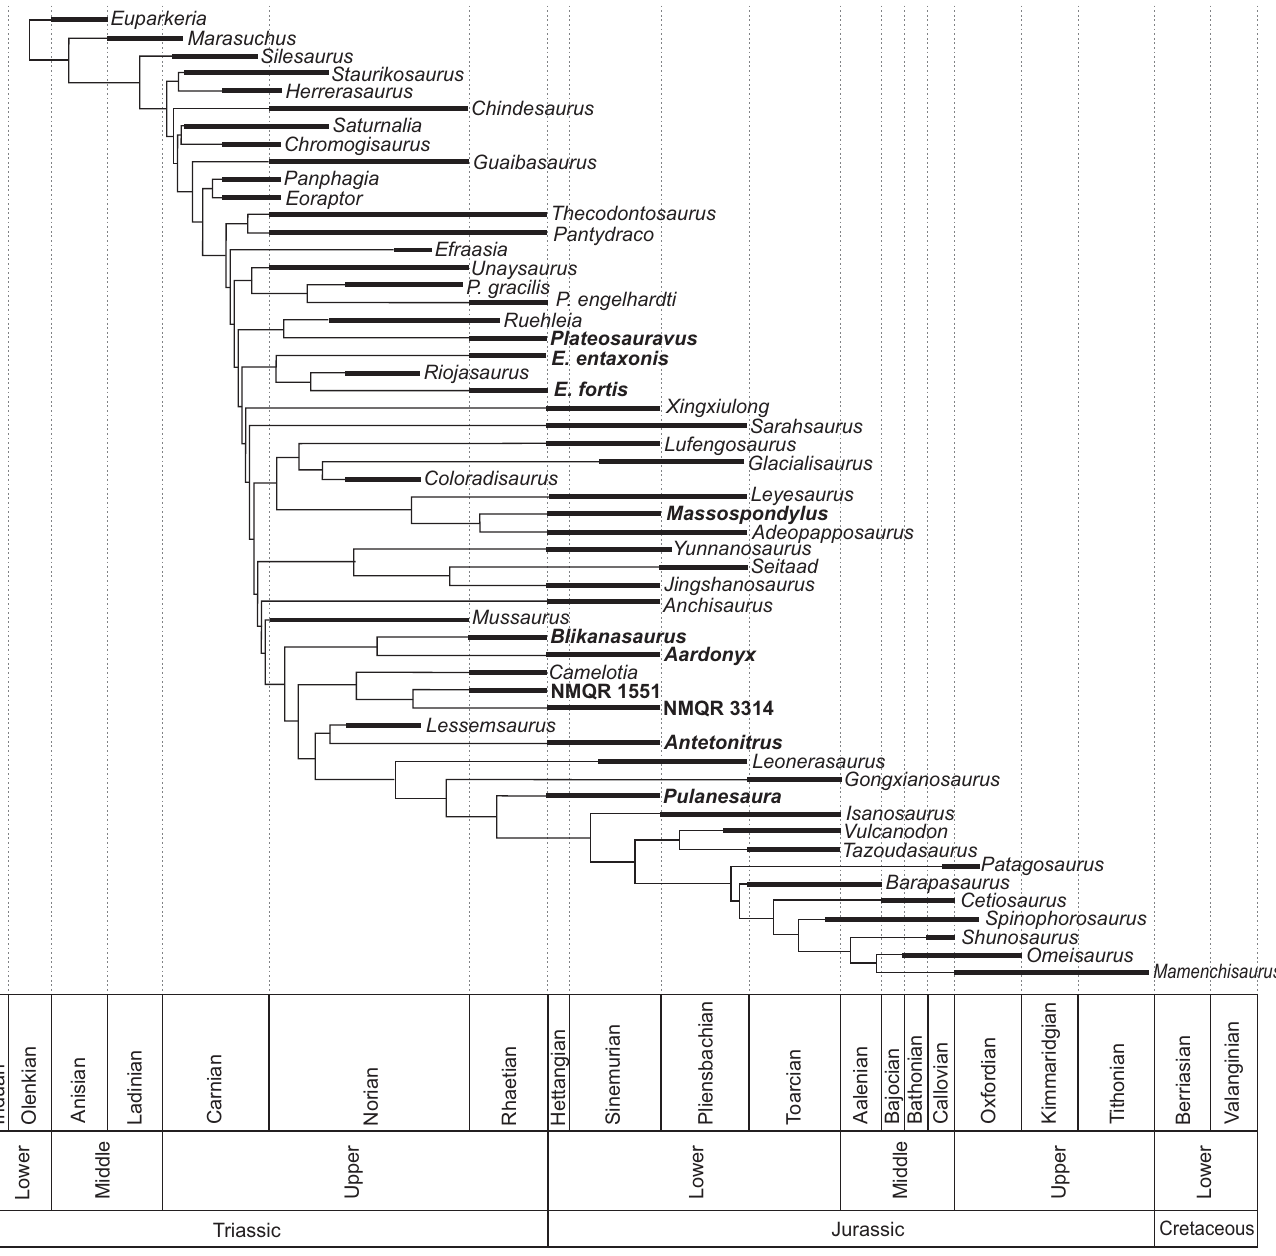
Fig. 6. The hypothesis of sauropodomorph biostratigraphic relationships presented within, reconstructed with “equal” branch lengths (Bell and Lloyd 2015). This tree represents the “best-fit” from amongst the 48 original MPTs as per the modified Gap Excess Ratio (GER). Note that although the genus Eucnemesaurus is paraphyletic in the current topology, the relationship ( E. entaxonis ( Riojasaurus + E. fortis )) is not supported by synapomorphies pres- ent in Riojasaurus and E. fortis and absent in E. entaxonis , and instead appears to be a reflection of the higher number of localised autapomorphies present in E. entaxonis compared to E. fortis . The highly incomplete nature of the specimens grouped under Eucnemesaurus , along with the possibly chimerical status of Riojasaurus (see McPhee et al. 2015b), presents issues that exceed the scope of the current study to adequately address. Specimens from Elliot Formation shown in